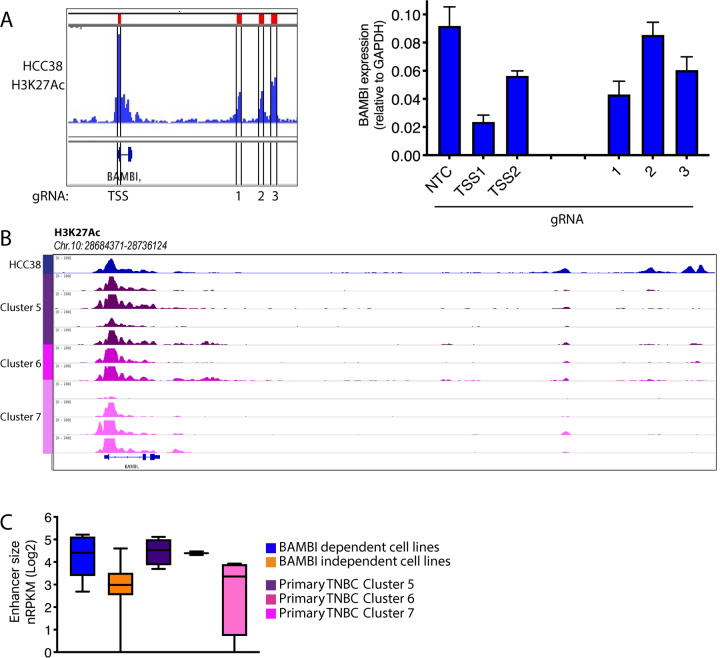
Enhancer regulation of BAMBI gene expression.A) Left panel shows H3K27Ac ChIP-Seq track of BAMBI-proximal region denoting enhancer peaks targeted by dCAS9-KRAB gRNAs. Right panel shows BAMBI expression by qPCR after cells were infected with the indicated gRNAs. B) Tracks show H3K27Ac ChIP-Seq signal of the BAMBI-proximal region in primary TNBC samples. C) Boxplot summarizing variant H3K27Ac peaks for the indicated groups. Box indicates median, 25th and 75th percentiles, whiskers indicate min and max.